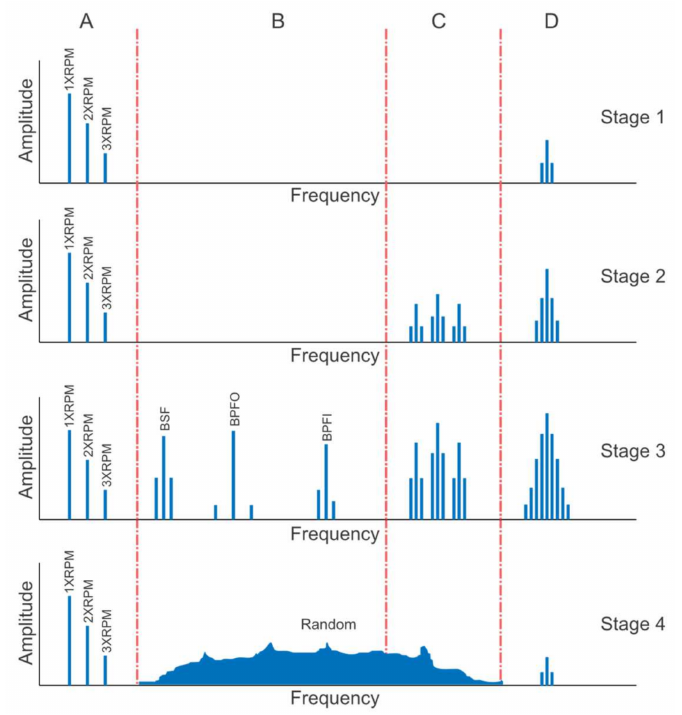
Figure 3. Stages of bearing life.